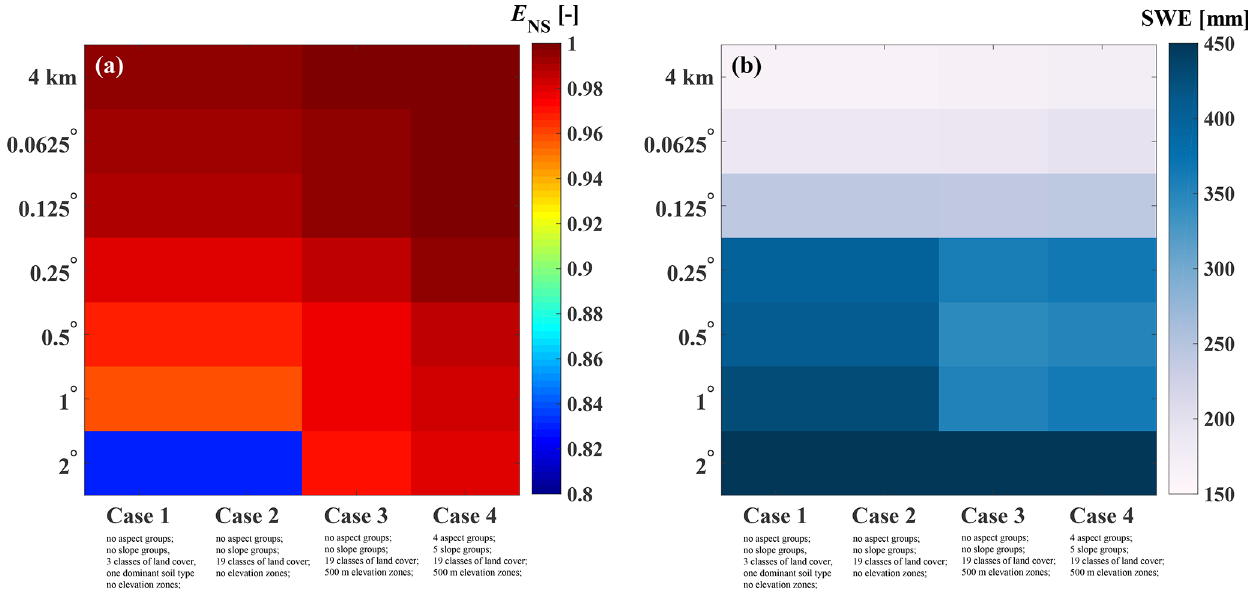
Figure 6. (a) The relative performance of model simulation across various configurations with a single parameter set. (b) Maximum of snow water equivalent for an arbitrary location of − 116 . 134 ◦ W and 51.382 ◦ E located in Bow Valley bottom across various model configurations for the year